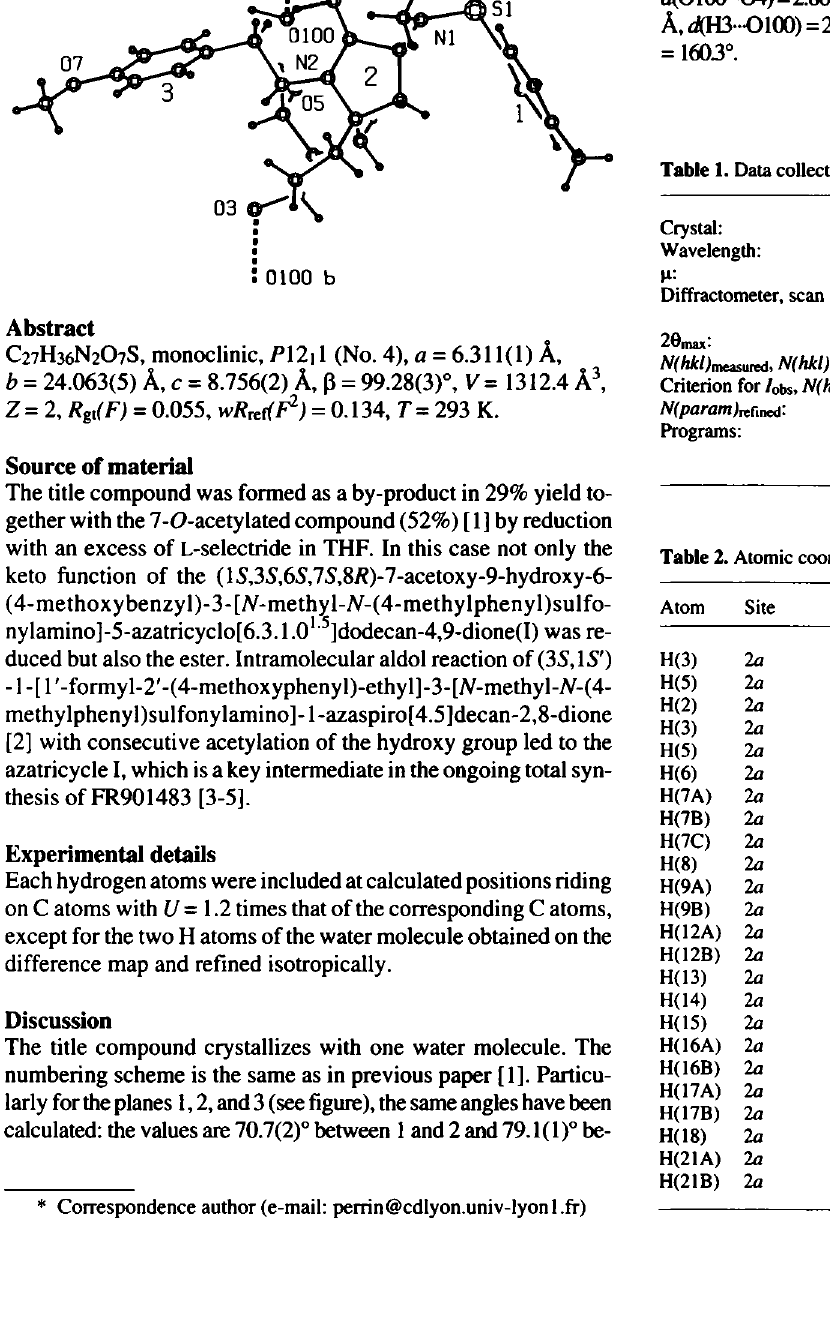
Table 1. Data collection and handling. Crystal: